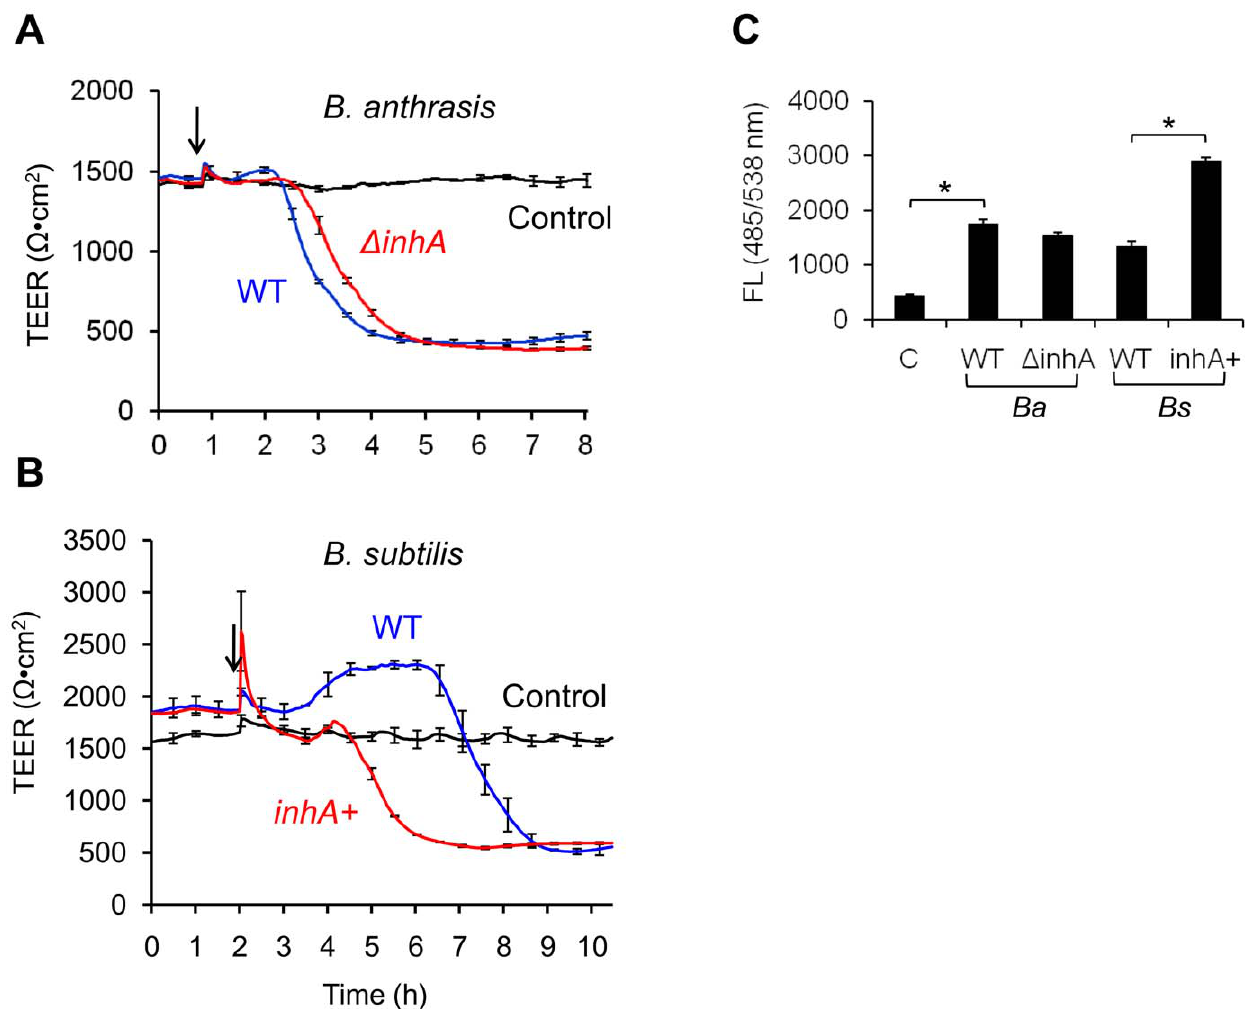
Figure 3. InhA contributes to increased permeability of infected HBMEC monolayers. (A, B) Real-time TEER of HBMECs (about 6 6 10 4 cells/ well) treated with D inhA of B. anthracis Ames 35 ( D inhA , red line in panel A) and InhA-expressing B. subtilis ( inhA + , red line in panel B) at MOI of 10. Signals corresponding to parental strains (WT) and culture medium without bacteria are shown as blue and black lines, respectively. Arrows indicate time points when bacteria were added to the cells. (C) Transwell permeability assays of HBMECs infected with B. anthracis ( Ba ) and B. subtilis ( Bs ) strains as indicated above for 4 h. Leakage of FITC-dextran added to the monolayers for 2 h was determined by measuring fluorescence in the bottom chamber at 485/538 nm. * P , 0.01.